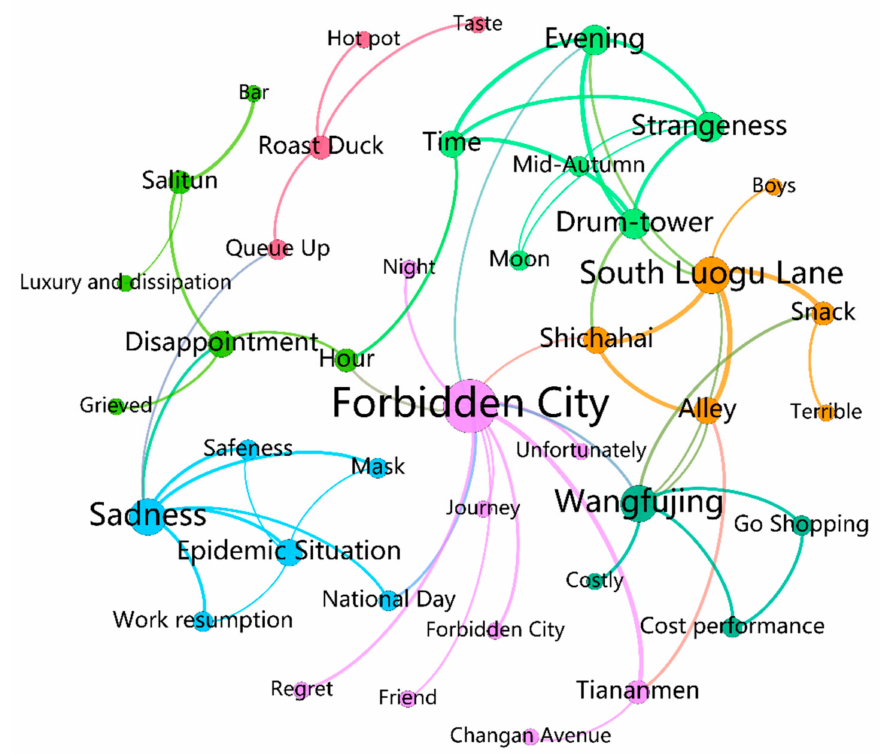
Figure A6. The negative sentiment profile of flows linked to attractions in the